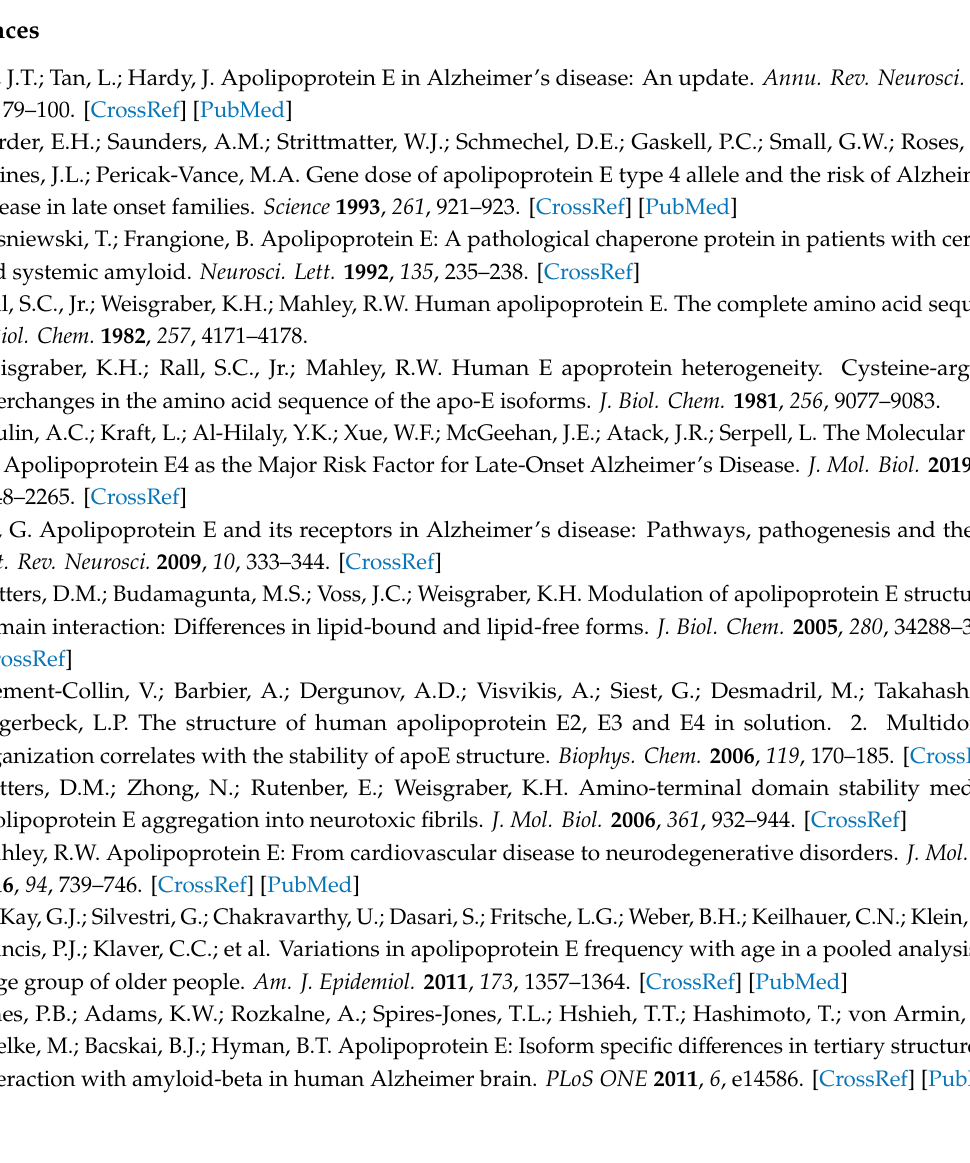
Figure S1: Analysis of ThT binding kinetics results in Figure 1 by Boltzmann sigmoid fitting. Figure S2: Interference of BSA with IAPP amyloid formation. Figure S3: TEM images showing larger field samples presented in Figure 2. Figure S4 ThT binding kinetics of IAPP aggregation in pericyte culture medium. Figure S5: WST-1 assay of pericyte viability after treatment with pre-incubated samples. Figure S6: LC-MS analysis showing the quality of IAPP (a) and ApoEs (b,c,d). Supplementary figure